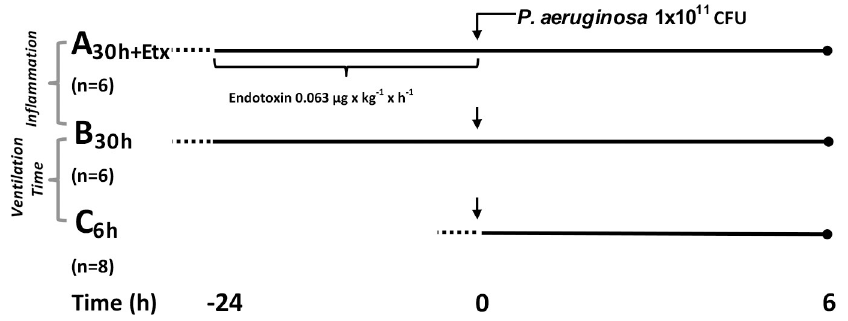
Fig 1. Experimental overview. Experimental parts Inflammation A 30h+Etx vs. B 30h , Ventilation Time B 30h vs. C 6h , Etx (endotoxin), dotted line indicates preparatory surgery of approximately 1 h, Pseudomonas ( P .) aeruginosa , CFU (colony forming unit), the bacterial phase is between 0–6 h, n (number of animals per group).